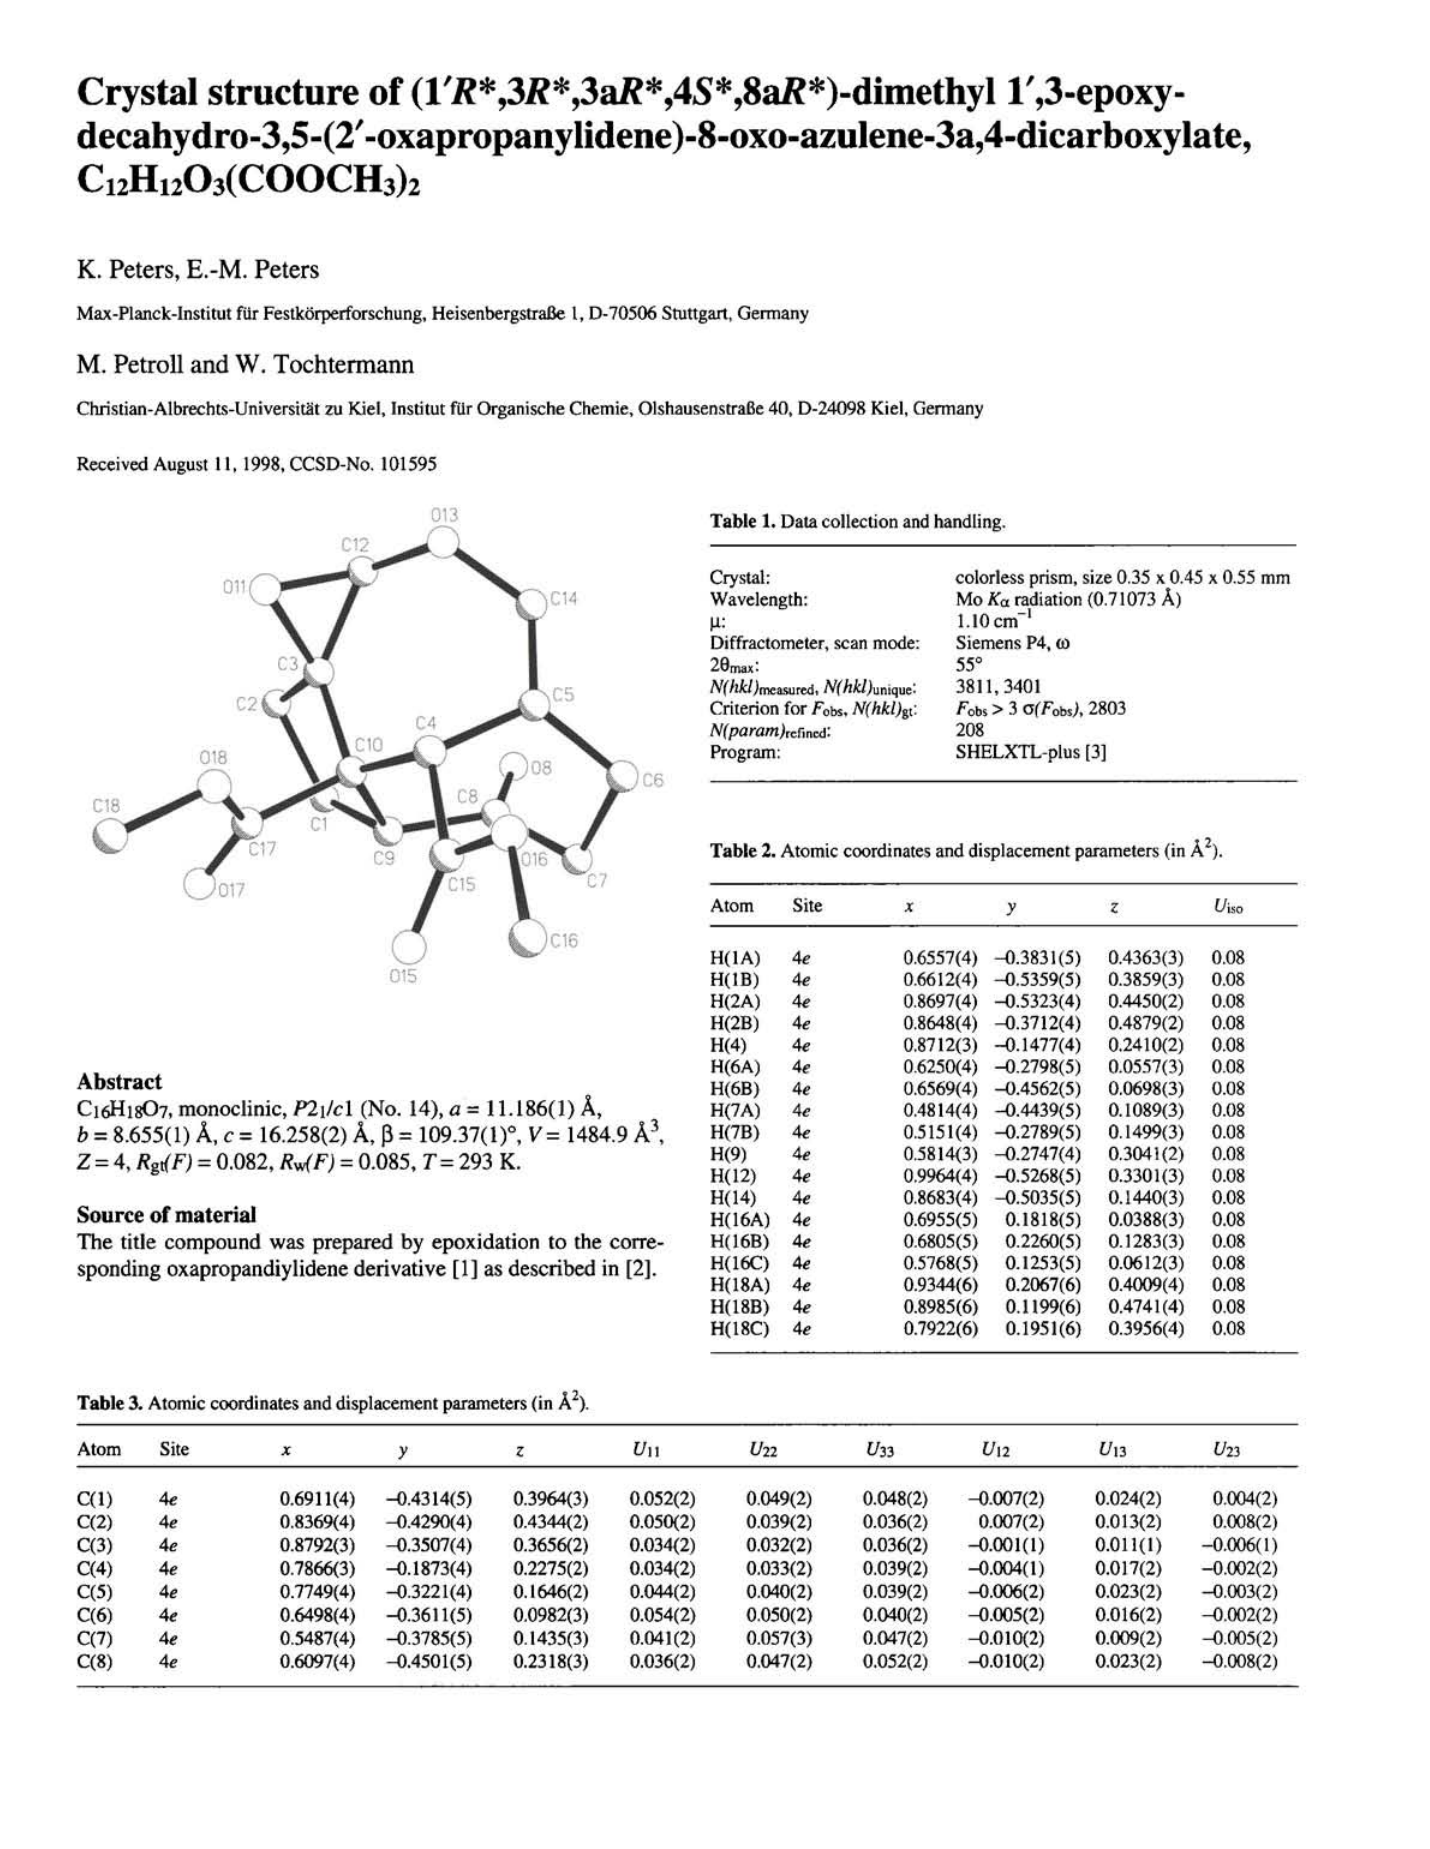
Table 1. Data collection and handling.